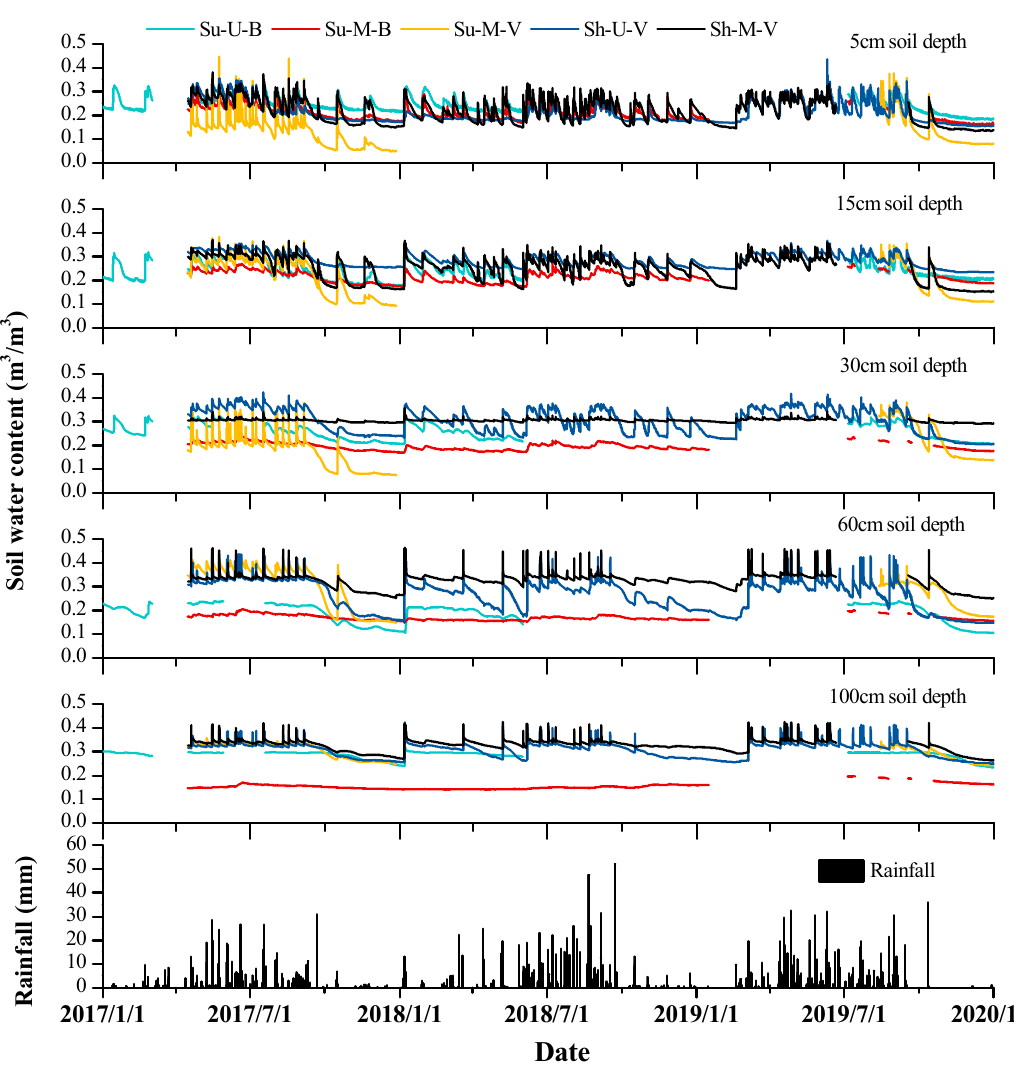
Figure 2. Rainfall and soil water content with five depths (5 cm, 15 cm, 30 cm, 60 cm and 100 cm) on the collapsing gully slope from January 2017 to December 2019. Table 3. Statistic values of soil water content in the five experimental sites of collapsing gully slope. Sites